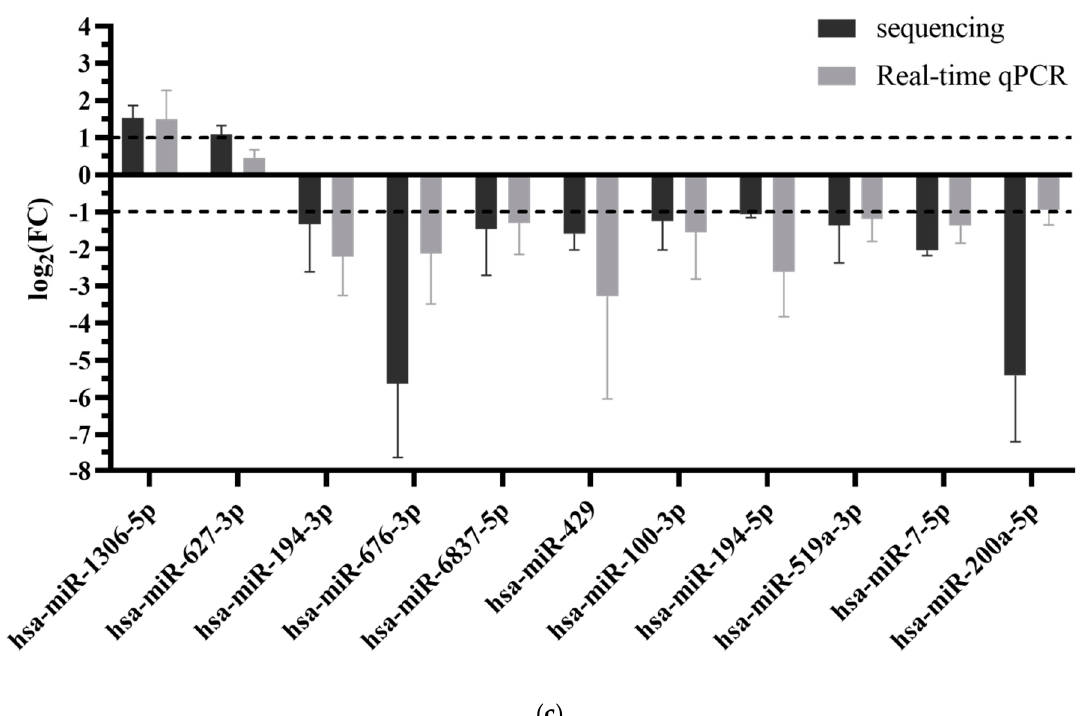
Figure 9. Relative mRNA and miRNA expression of the control group and the naringenin group, in respect to RNA-seq and real-time qPCR. ( a ) The 19 genes involved in liver metabolism; ( b ) 11 genes involved in the PI3K–Akt signaling pathway; ( c ) 11 putative regulatory miRNAs. Y-axis represents log 2 (FC); FC (fold change) = the naringenin group/the control group. The dashed line indicated fold change data of 2.0. Values are the mean ± SD ( n = 4).